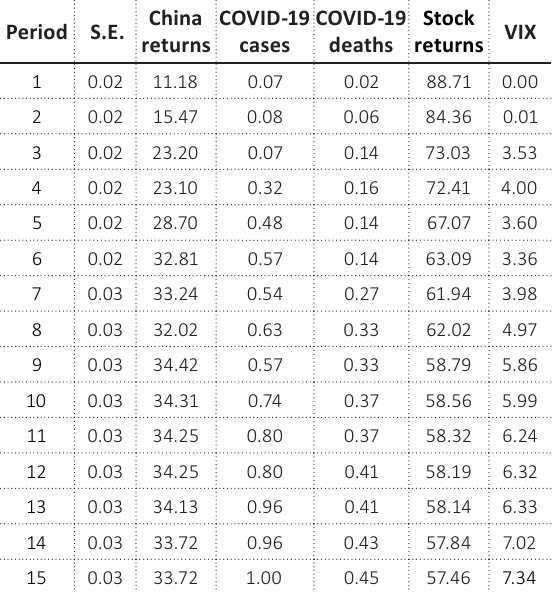
Table 1. Contribution of Chinese returns, forecast error variance of European stock returns